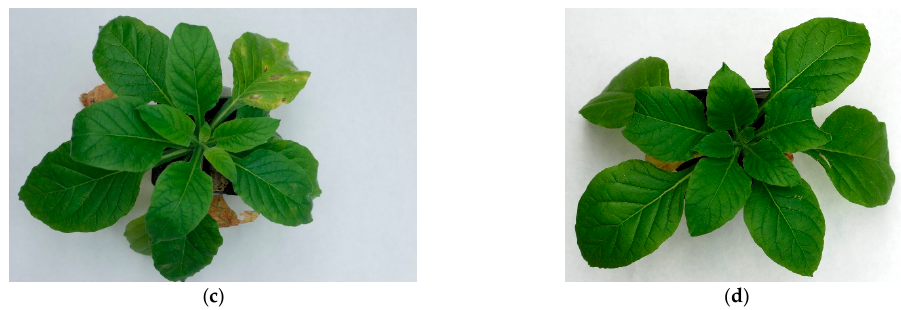
Figure 3. Response of Nicotiana mutabilis to TSWV four weeks after inoculation: ( a ) chlorotic spots (CS); ( b , c ) chlorotic and necrotic spots (NeS); ( d ) mock inoculated plant without symptoms.